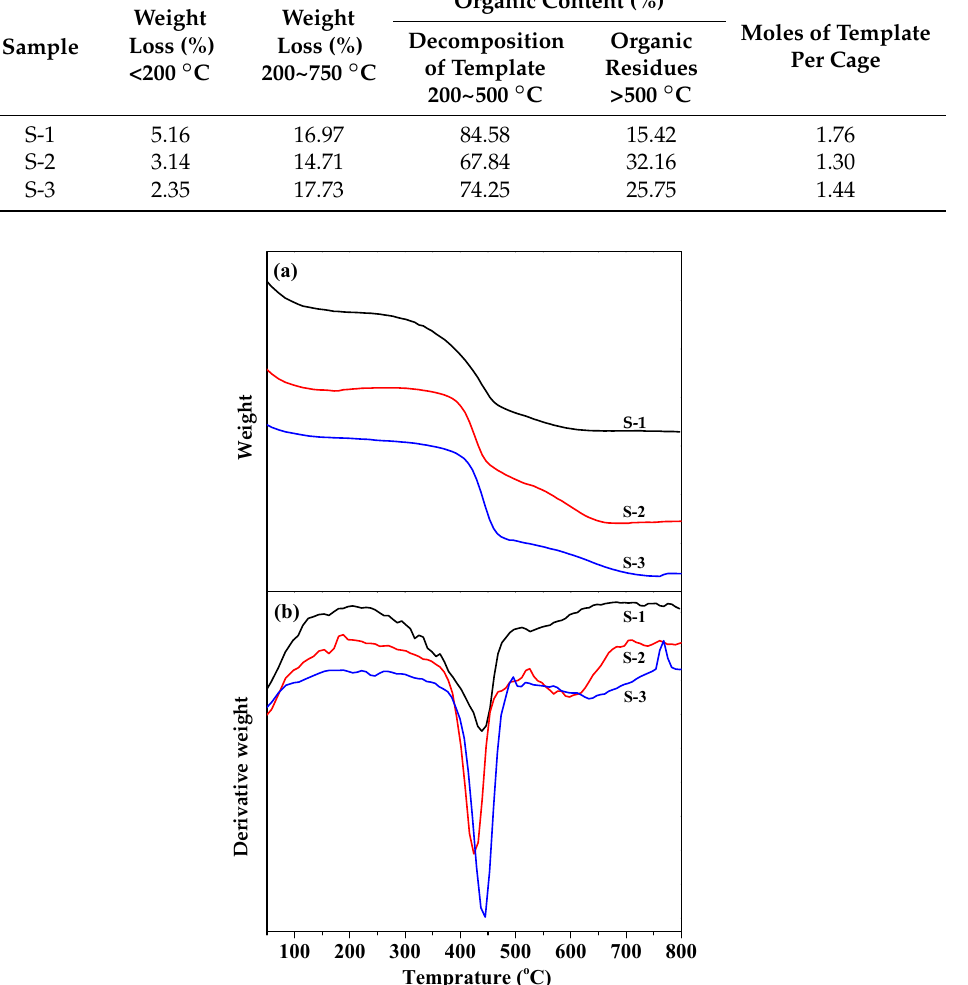
Figure 3. The TG-DTG curves for samples with different templates, a: TG curve, b: DTG curve. Table 2. The TG analysis results for samples synthesized by different templates.